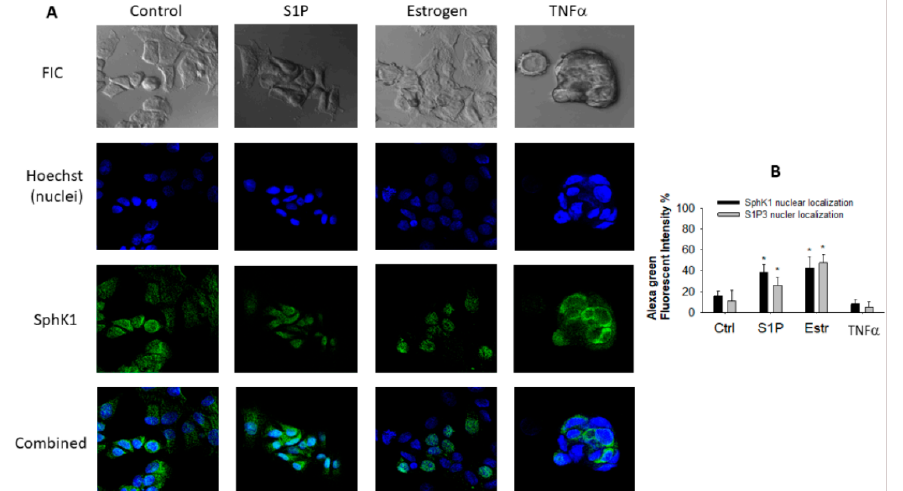
Figure 3. SphK1 intracellular localization in parental MCF-7 cells. ( A ) SphK1 intracellular localization was assessed using IF and confocal microscopy in cells treated with vehicle (Ctrl), or treated with 10 nM Estrogen, 500 nM S1P, or 100 ng/mL TNF α for 3 h. The 3 h timepoint was optimized in pilot studies to identify significant effects on trafficking. Endogenous SphK1 protein (green) was visualized using Alexa 488-conjugated secondary antibodies. Hoechst (blue) was used to mark cell nuclei. ( B ) Alexa-488 (green) and Hoechst (blue) co-localization percent was estimated in MCF-7 cells treated as described in the Methods (* p -value < 0.05). S1P3 nuclear localization was estimated using IF imaging as shown in Figure 4. Total Alexa-488 fluorescence intensity per analysed image area was taken as 100%. Images are representative of at least 3 independent experiments.